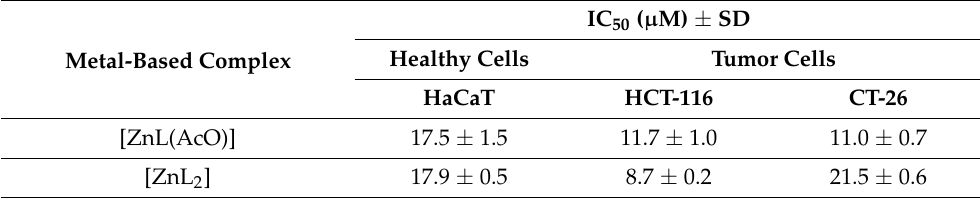
Table 1. In vitro antiproliferative effect of metal complexes [ZnL(AcO)] and [ZnL 2 ] after incubation in HaCaT, HCT-116, and CT-26 cell